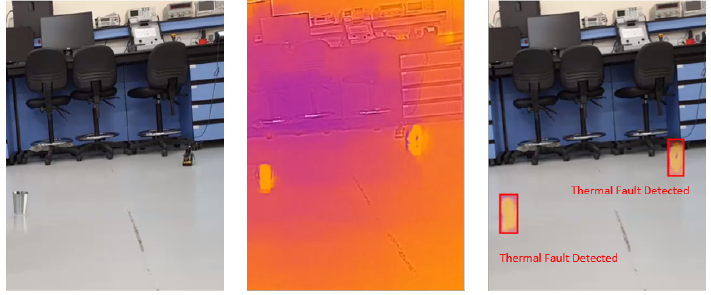
Figure 20. Thermal anomalies detection in lab environment 1.